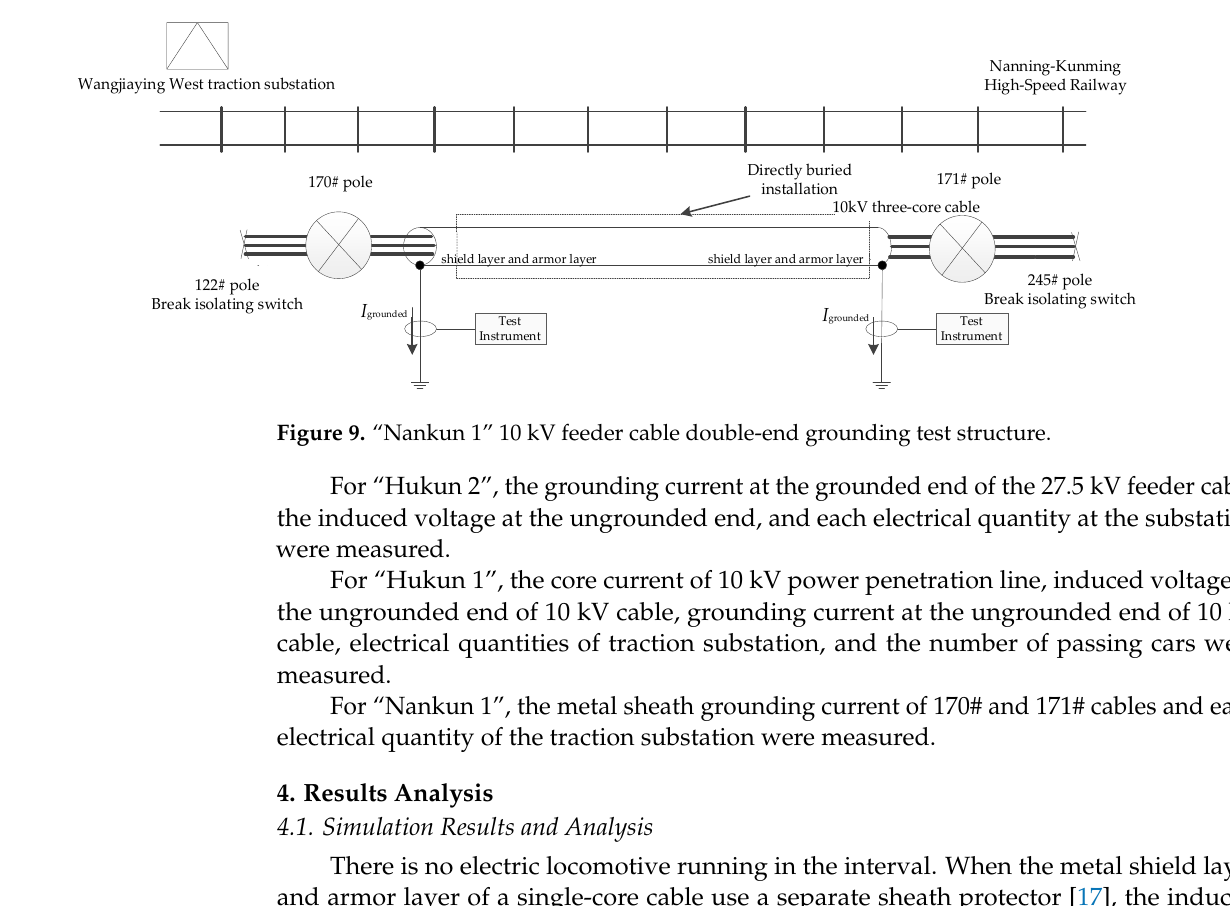
Figure 8. “Hukun 2” 27.5 kV feeder cable double-end grounding test structure.